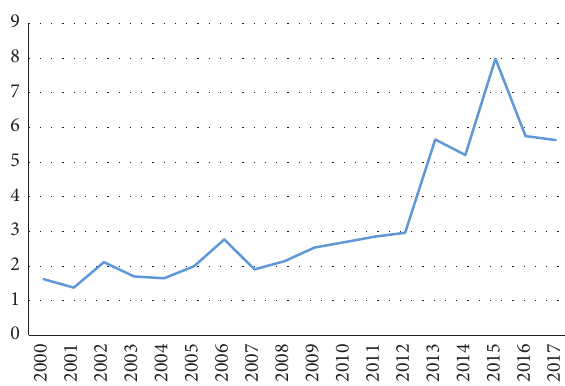
Figure 5: Effective scale evolution of China’s nonferrous metal collaborative innovation